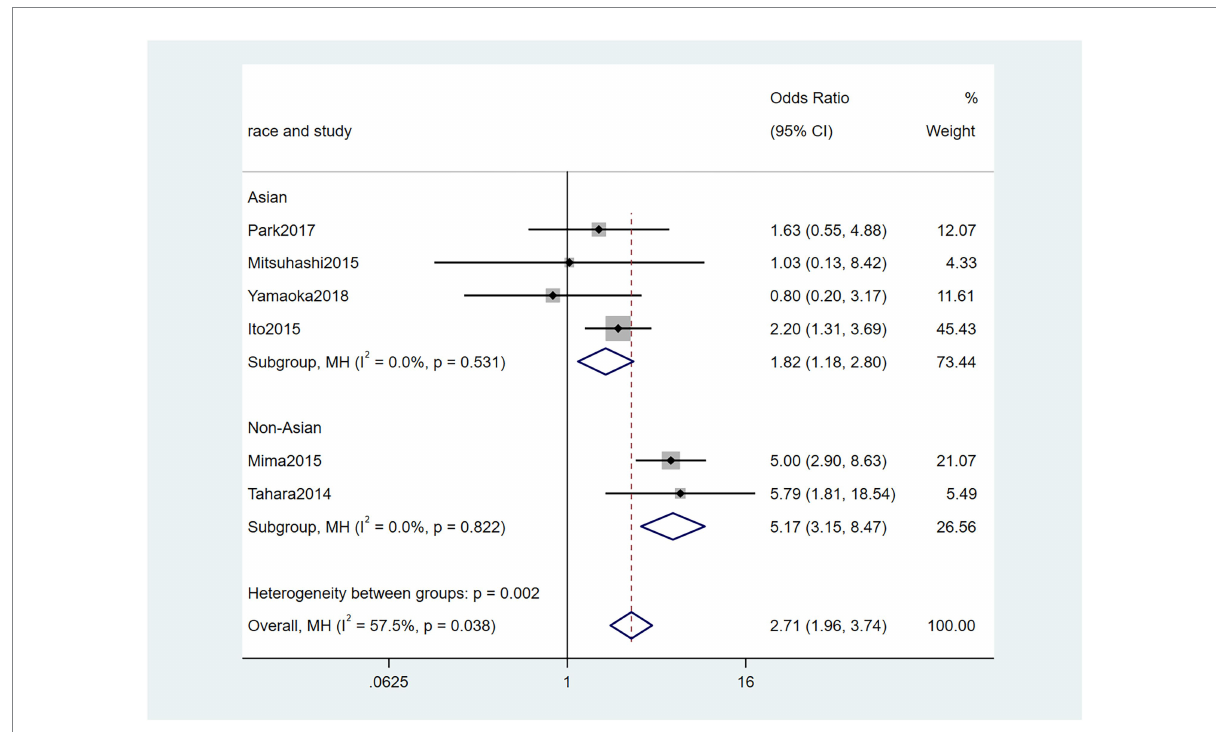
FIGURE 6 Forest plot of the relationship between Fusobacterium nucleatum and MLH1 methylation in